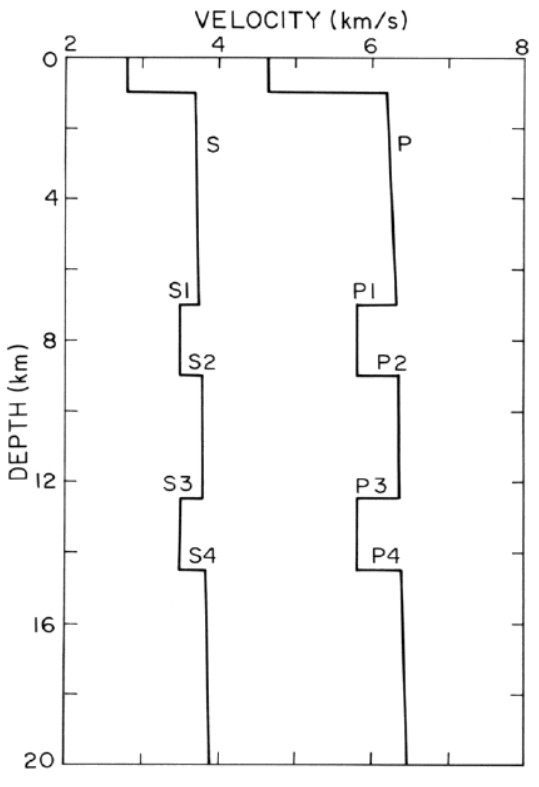
Figure 2. Upper crustal P and S velocity models used to compute the synthetic seismogram gathers shown in Figures 3-7 to illustrate variations of the local earthquake seismogram characteristics for different source mechanisms. Note the significant stratification in the upper crust that is examined as to how well the P and S reflec- tions and the P-to-S conversions can be recognized in various syn- thetics for different source